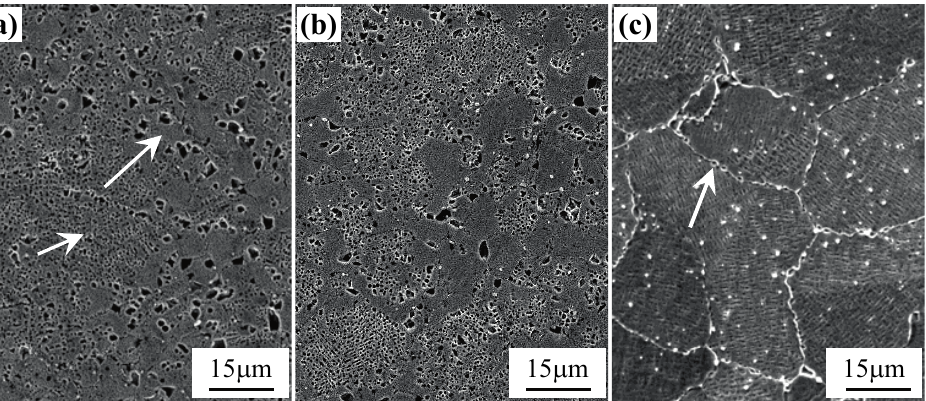
Figure 3. After fully heat treated, microstructure of HIP treated alloy at different temperatures. (a) After the 1120 ı C HIP alloy was fully heat treated, fine (cid:2) 0 dispersedly precipitated in the grain as marked with short arrow, and (cid:2) 0 -phase free zone appeared around the coarser (cid:2) 0 phase as marked with longer arrow, (b) after the 1150 ı C HIP alloy was fully heated treated, fine (cid:2) 0 phase dispersedly distributed in the grain, (c) after the 1180 ı C-HIP alloy was fully heat treated, there are a few of smaller primary (cid:2) 0 phase discontinuously precipitated along the boundary